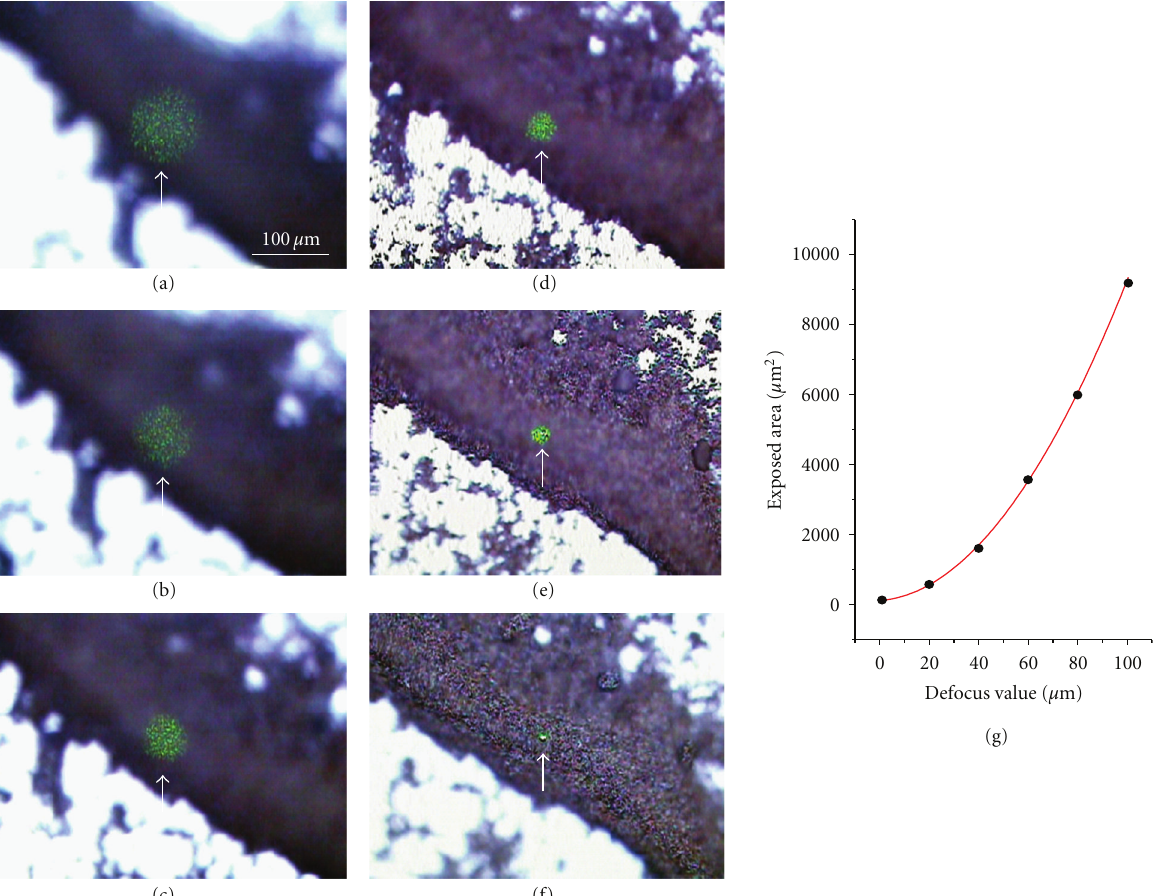
Figure 3: Optical microscopy images of the samples of C 60 NWs irradiated by the excitation laser beams for the defocus values (under focus) of (a) 100, (b) 80, (c) 60, (d) 40, (e) 20, and (f) 0 µ m and for the arrowed exposed areas of (a) 9270, (b) 6630, (c) 3480, (d) 1470, (e) 617, and (f) 63.8 µ m 2 , respectively. Graph (g) shows the relationship between the defocus value and the exposed